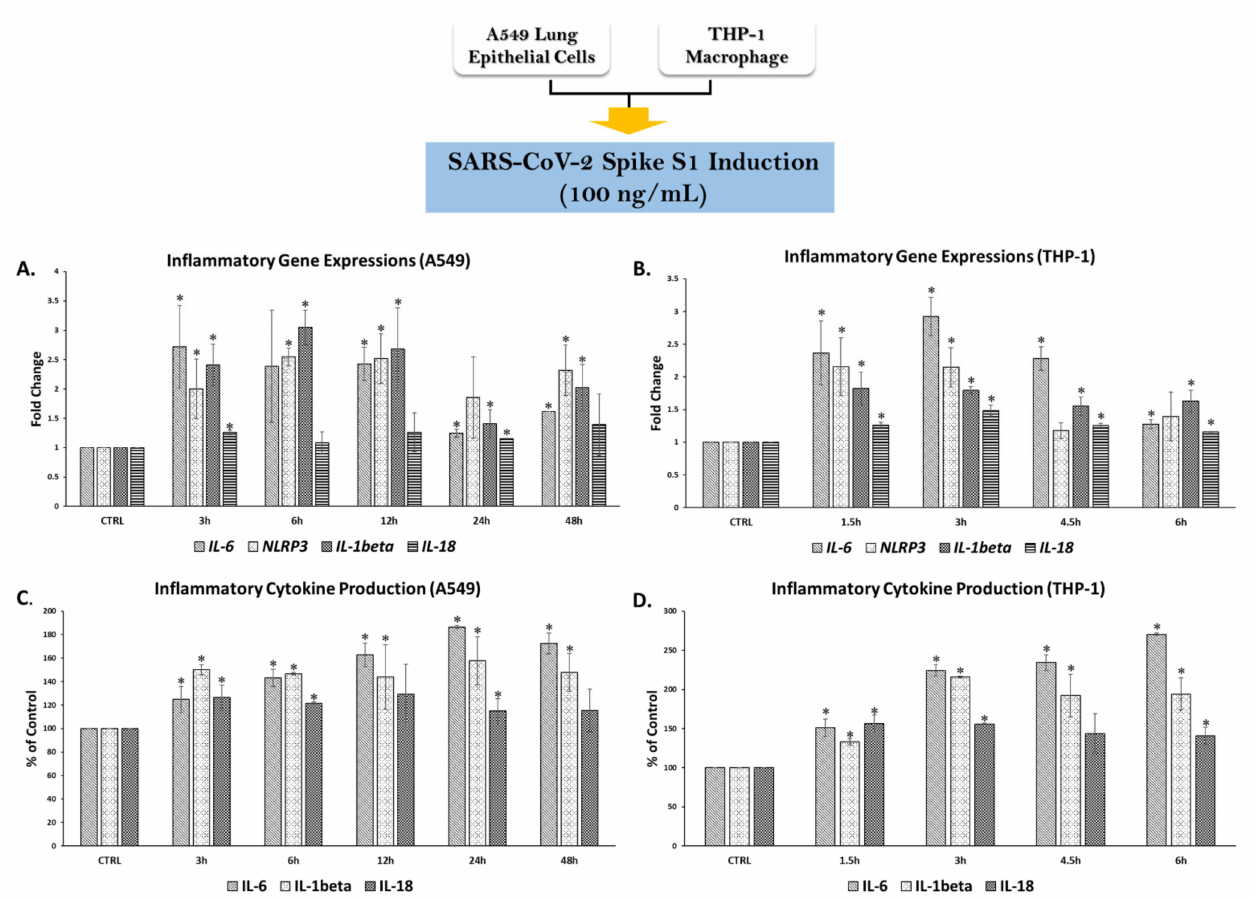
Figure 3. Establishing the inflammatory response upon spike S1 glycoprotein induction in A549 lung cells and THP-1 macrophages. PMA-treated THP-1 macrophage (6.5 × 10 5 cell/well) and A549 (at 3 × 10 5 cell/well) were seeded in 6-well plates and incubated overnight, then challenged with 100 ng/mL of spike glycoprotein S1 (SP) for 0–48 h for A549 and 0–6 h for THP-1 macrophage and the supernatants were collected and the cells were extracted for total RNA using TRIzol ® reagent. The fold-change of inflammatory gene expressions ( NLRP3 , IL-1 β , and IL-18 ) in response to SP induction in A549 cells ( A ) and in THP-1 macrophages ( B ) were determined using RT-PCR. The inflammatory cytokine secretions (IL-6, IL1 β , and IL-18) in A549 cells ( C ) and in THP-1 macrophages ( D ) upon SP induction were determined using ELISA. Data are presented as mean ± S.D. values of at least three independent experiments. * p < 0.05 vs. non-treated control group. SARS-CoV-2, severe acute respiratory syndrome coronavirus 2; IL-6, Interleukin-6; NLRP3, Nucleotide-binding oligomerization domain-like receptor containing pyrin domain 3; IL-1 β , interleukin-1 β ; IL-18,